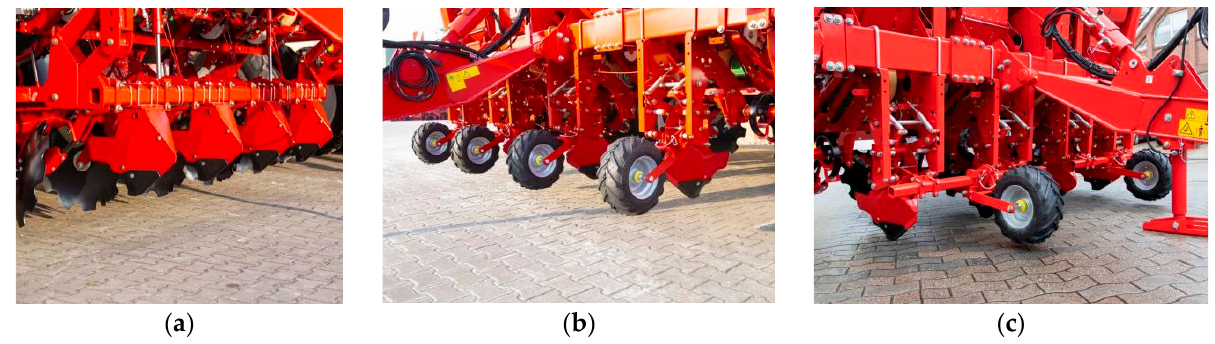
Figure 25. Grimme GB 430 potato planter. ( a ) Trailed furrow openers of GB430. Reprinted with permission from ref. [89] Copyright 2022 Grimme Industries; ( b ) Structure for lighter soils. Reprinted with permission from ref. [89] Copyright 2022 Grimme Industries; ( c ) Structure for heavy soils. Reprinted with permission from ref. [89] Copyright 2022 Grimme Industries.